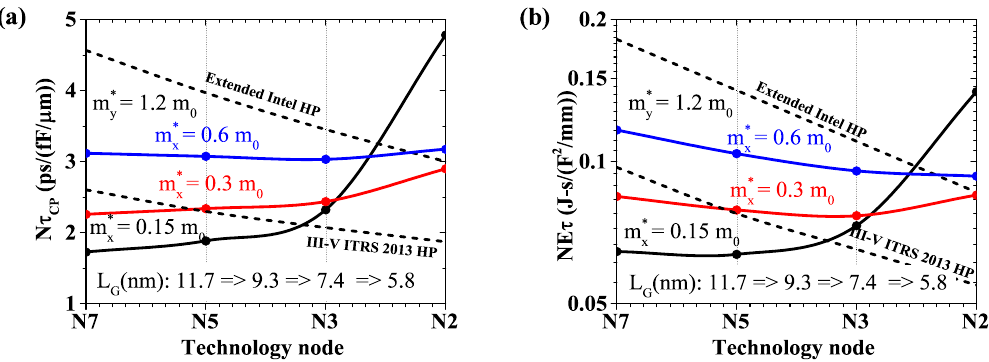
Figure 3. Performance of DG monolayer 2D FET at different technology nodes ( a ) Normalized delay and ( b ) Energy-delay product, showing the effect of gate length scaling of a smaller effective mass material such as monolayer black phosphorus (BP) ( ⁎ m